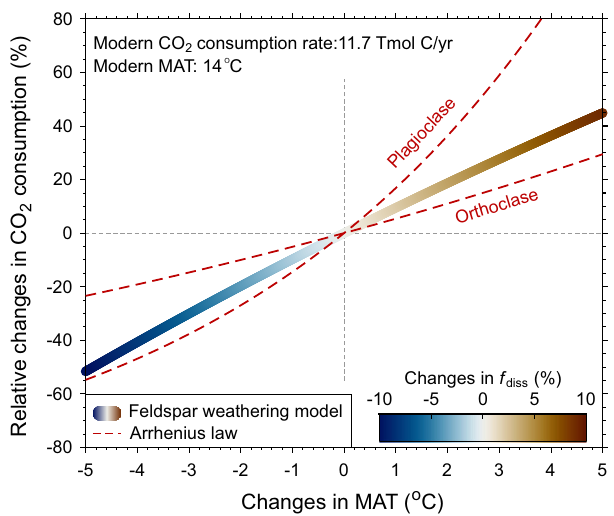
Fig. 6 Response of modeled silicate weathering-driven CO 2 consumption to changes in MAT. The modeled link is derived from the feldspar weathering model based on MAT- f diss equation in Fig. 4c. The changes in both MAT and CO 2 consumption are relative to the modern conditions. Note that changes in CO 2 consumption here are estimated from Ca, Na, and K only (mobile elements in feldspar) without Mg, and thus represent a conservative estimate. First-order estimates on the temperature dependence of weathering reactions by the Arrhenius law are shown for comparison. The range of activation energy used is 36 kJ/mol (orthoclase) to 107 kJ/mol (plagioclase) 70 . Details on the feldspar weathering model are described in